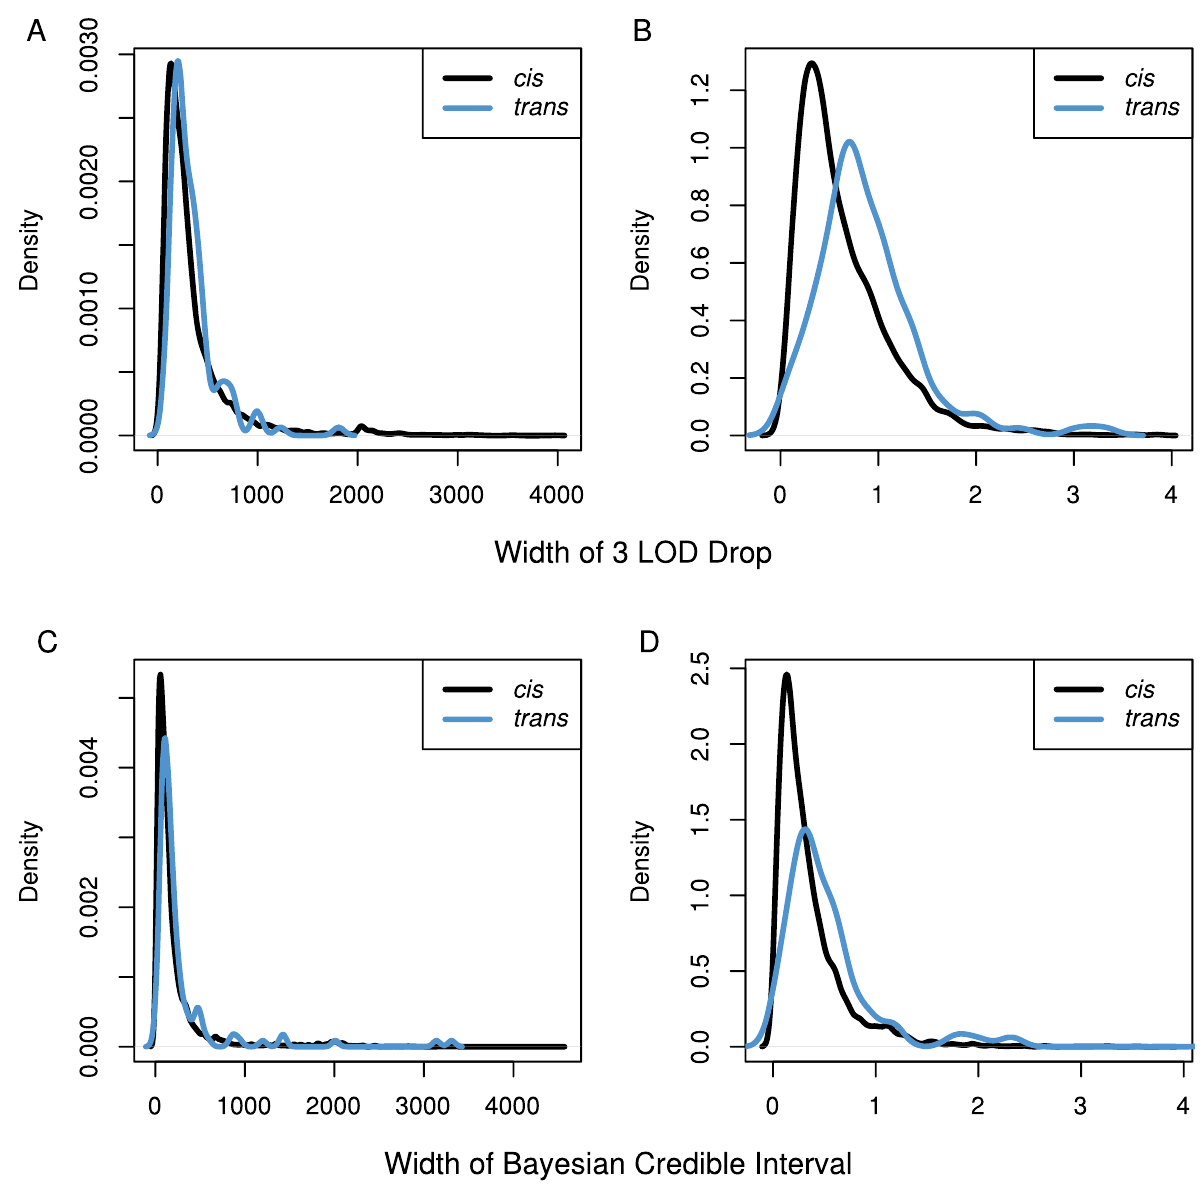
Figure 3. Distributions of the width of our confidence intervals for eQTL in A & C) physical distance (kb) and B & D) genetic distance (cM) using either a 3 LOD drop (A & B) or the Bayesian credible interval (C & D). Black lines show CIs for cis -eQTL while blue lines show CIs for trans -eQTL.